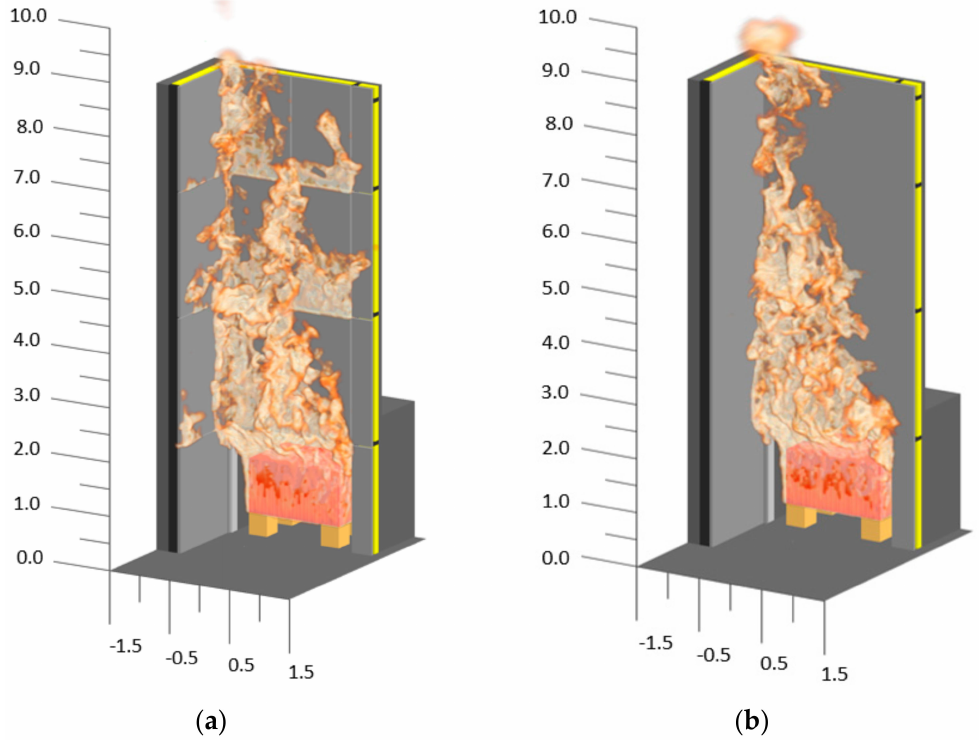
Figure 15. Flame spread after 6 min for gap and no-gap scenarios. ( a ) S1 model with ACP gaps, ( b ) S5 model with no ACP